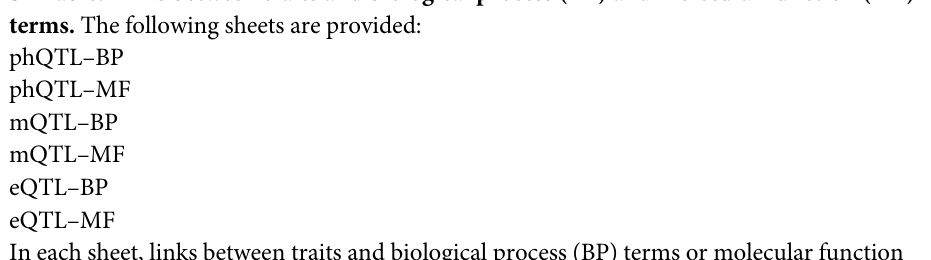
S1 Table. Characteristics of rice gene function annotation. Rice gene function terms were predicted using BMRF for biological process (BP) terms and Argot2 for molecular function (MF) terms. The total number of annotations, the number of genes with at least one annota- tion, and the unique number of gene function terms involved is shown. S2 Table. Links between traits and biological process (BP) and molecular function (MF) terms. The following sheets are